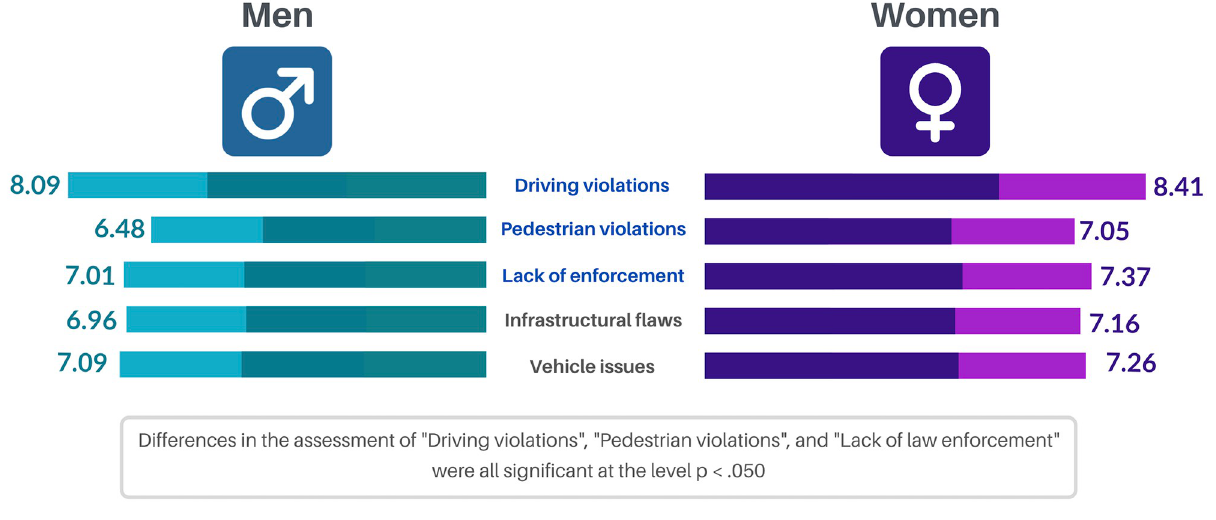
Fig 4. Assessment of the importance of risk factors for road crashes by sex of the respondent.